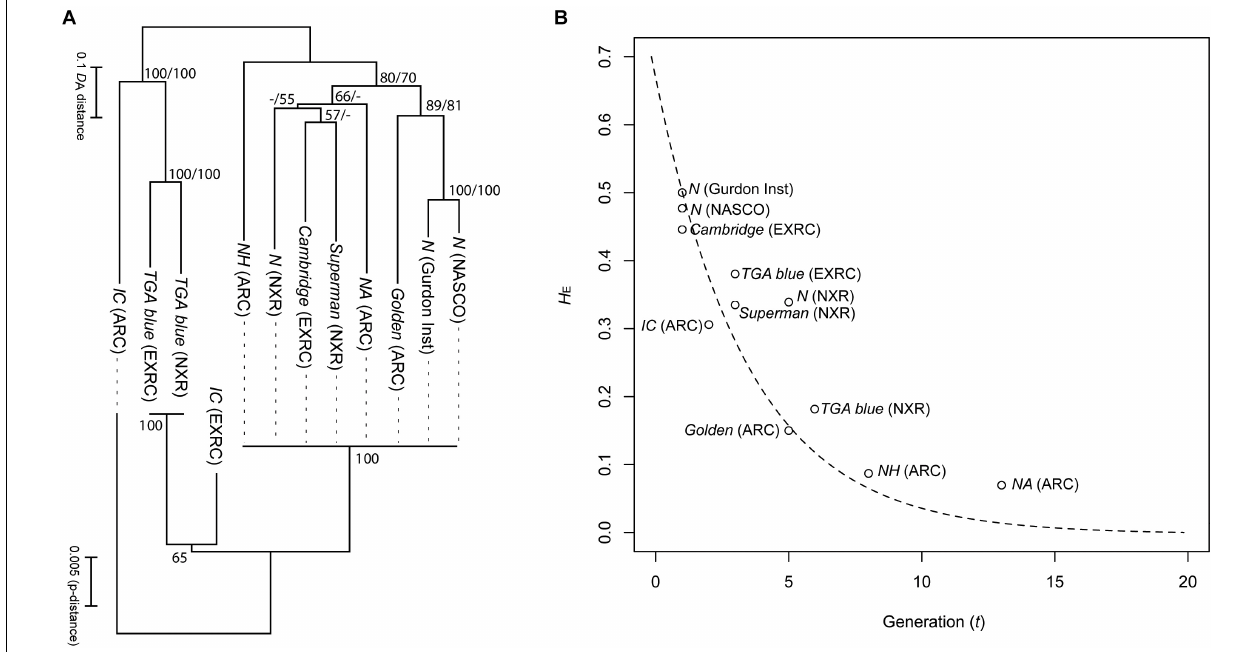
FIGURE 2 | Genetic relationships and heterozygosity reduction curve in the strains of X. tropicalis . (A) Neighbor joining trees of the strains based on genetic distances ( D A ) of 60 Simple Sequence Length Polymorphism (SSLP) markers (upper) and p-distance of mitochondrial haplotypes (2,328 bp; lower). Numbers on branches indicate percent bootstrap probability (only indicated > 50%). (B) Plot of expected heterozygosity ( H E ) against generation number ( t ). The curved dotted strain indicates theoretical reduction of heterozygosity via single brother-sister matings for every generation, calculated from the following (cid:18) (cid:19) t 1 − 1 2 N equation: H E = H 0 e